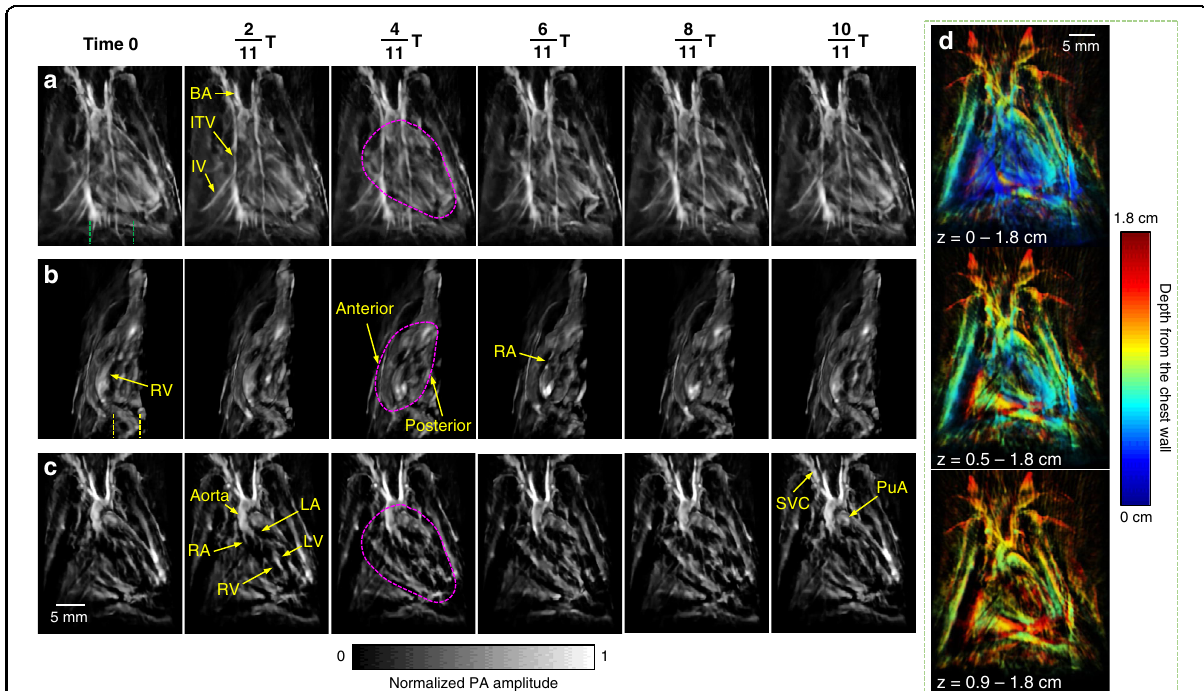
Fig. 2 Rat heart anatomy acquired by the 3D-PACT. a Front view of the heart within a cardiac cycle. The heart is identi fi ed by a magenta circle at 4 T. BA, brachiocephalic artery; ITV, internal thoracic vessels; IV, intercostal vessels. b Cross-sectional images of the heart on the sagittal plane. Each 11 image is a maximum amplitude projection (MAP) of a slice marked by the green dashed lines in ( a ) (Time 0). c Cross-sectional images of the heart on the coronal plane. Each image is an MAP of a slice marked by the yellow dashed lines in ( b ) (Time 0). LA, left atrium; LV, left ventricle; PuA, pulmonary artery; RA, right atrium; RV, right ventricle; SVC, superior vena cava. d The same data (at Time 0) shown with color-encoded depths. Shallower structures were peeled away in the lower images to show the posterior